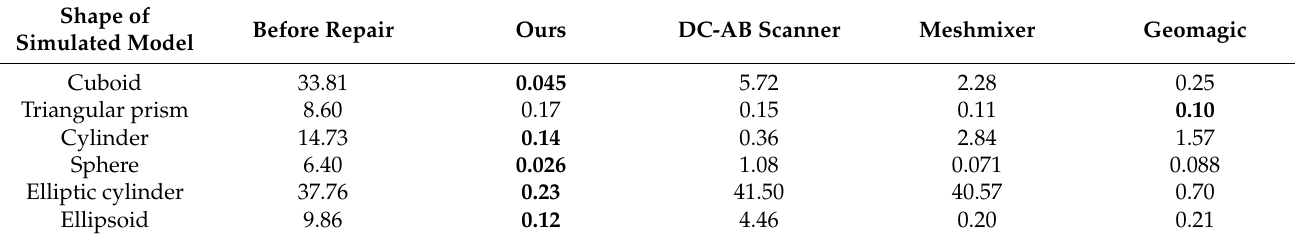
Table 1. The chamfer distance between each simulated model and ground truth before and after repair. Shape of Simulated